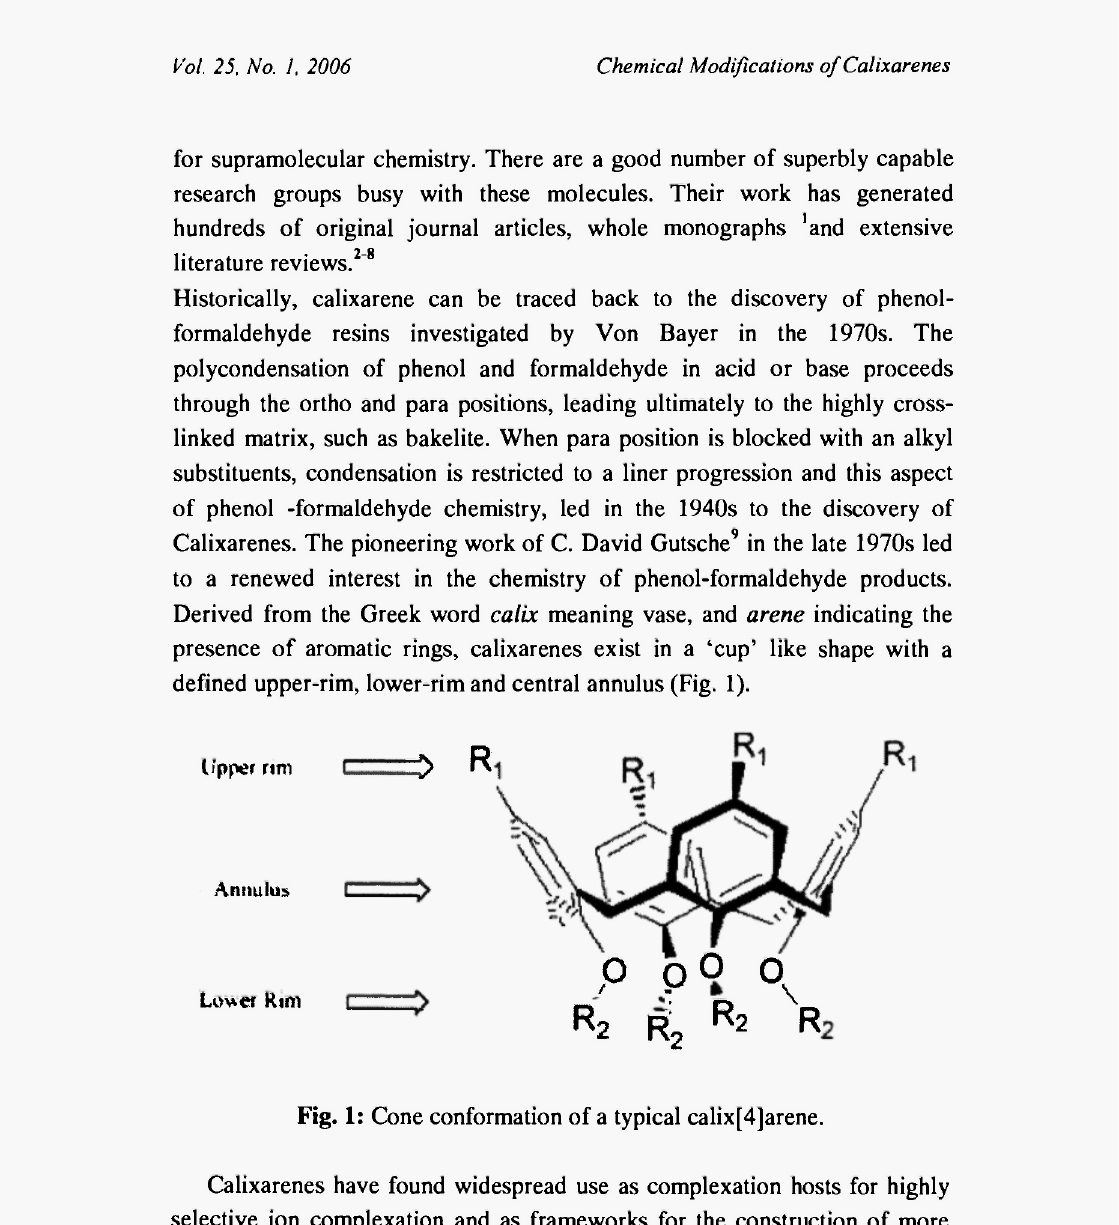
Fig. 1: Cone conformation of a typical